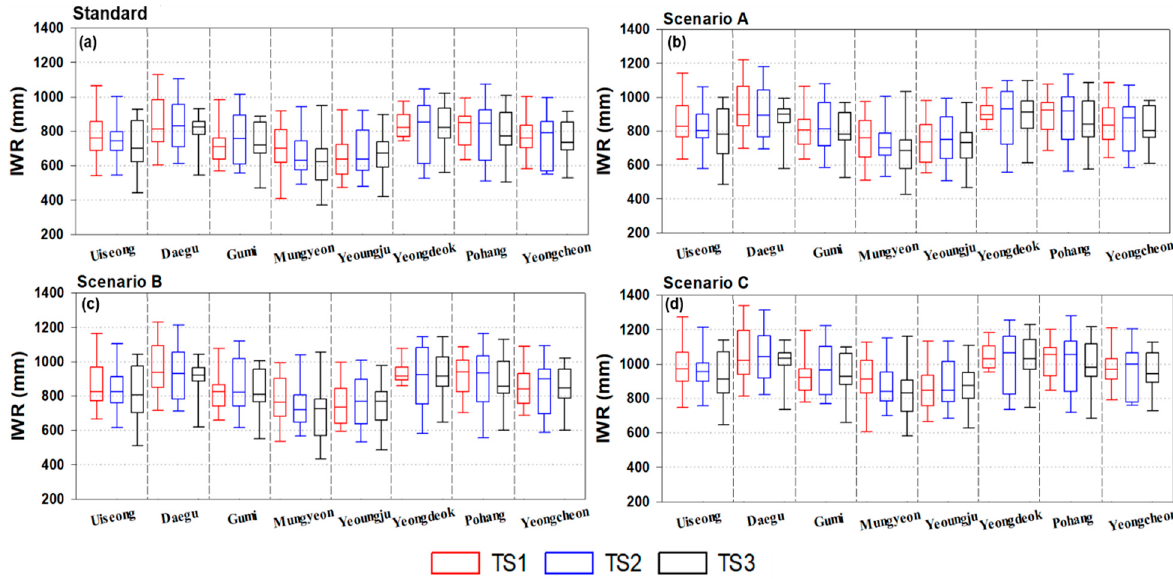
Figure 4. Variations in irrigation water requirement (IWR) depending on transplanting scenarios: ( a ) standard, ( b ) A, ( c ) B, and ( d ) C during the TS1 (1973–1987), TS2 (1988–2002) and TS3 (2003–2017). Description of the transplanting scenarios is provided in Table 2.